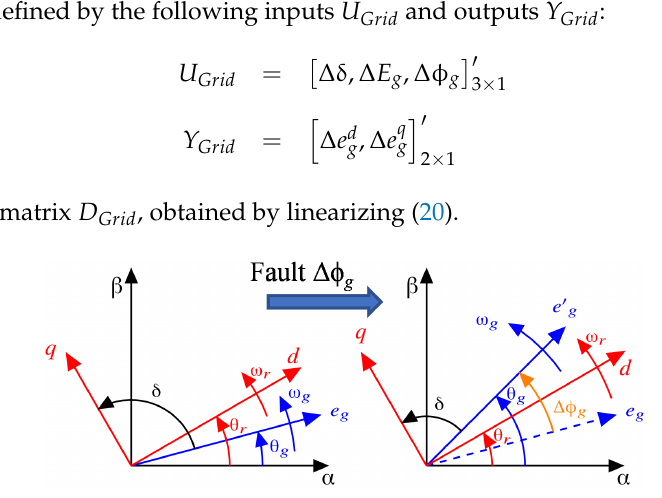
Figure 7. Vector diagram of the grid voltage and the ( d , q ) S-VSC rotating reference frames. The angle ∆ φ g is defined as the load angle variation after a fault